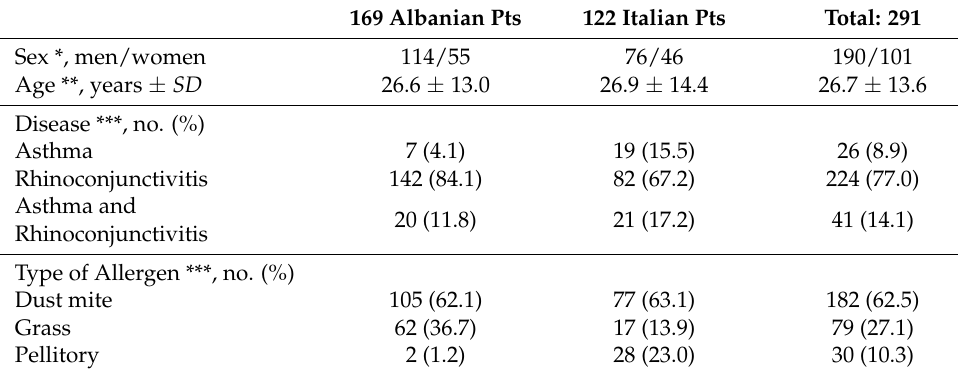
Table 1. Demographic and allergological characteristics of enrolled patients.